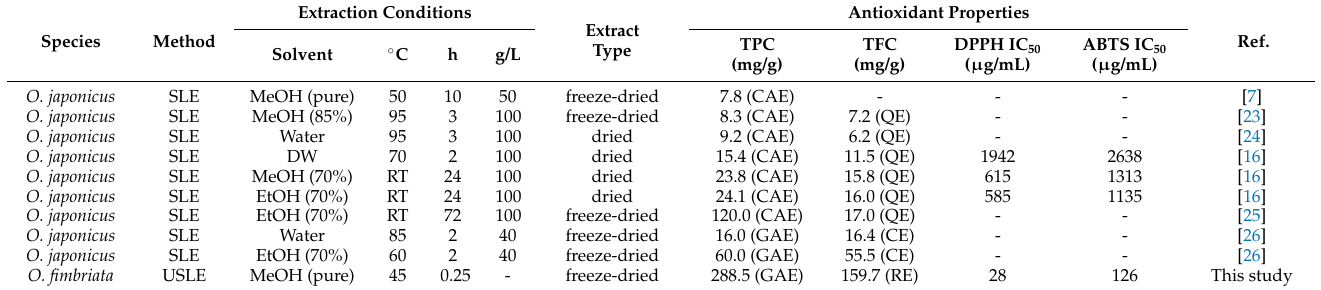
Table 2. Summary of the antioxidant content and activity of extracts from Orostachys